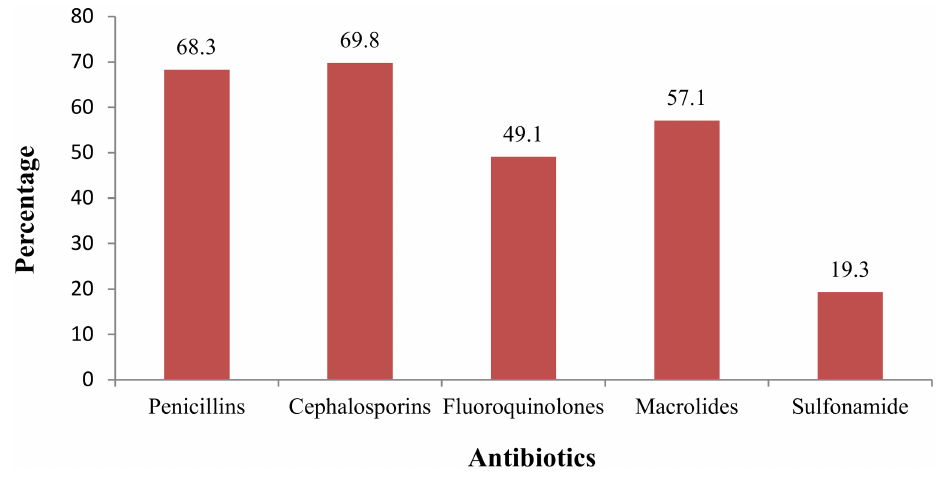
Fig 2. Dispensing pattern of